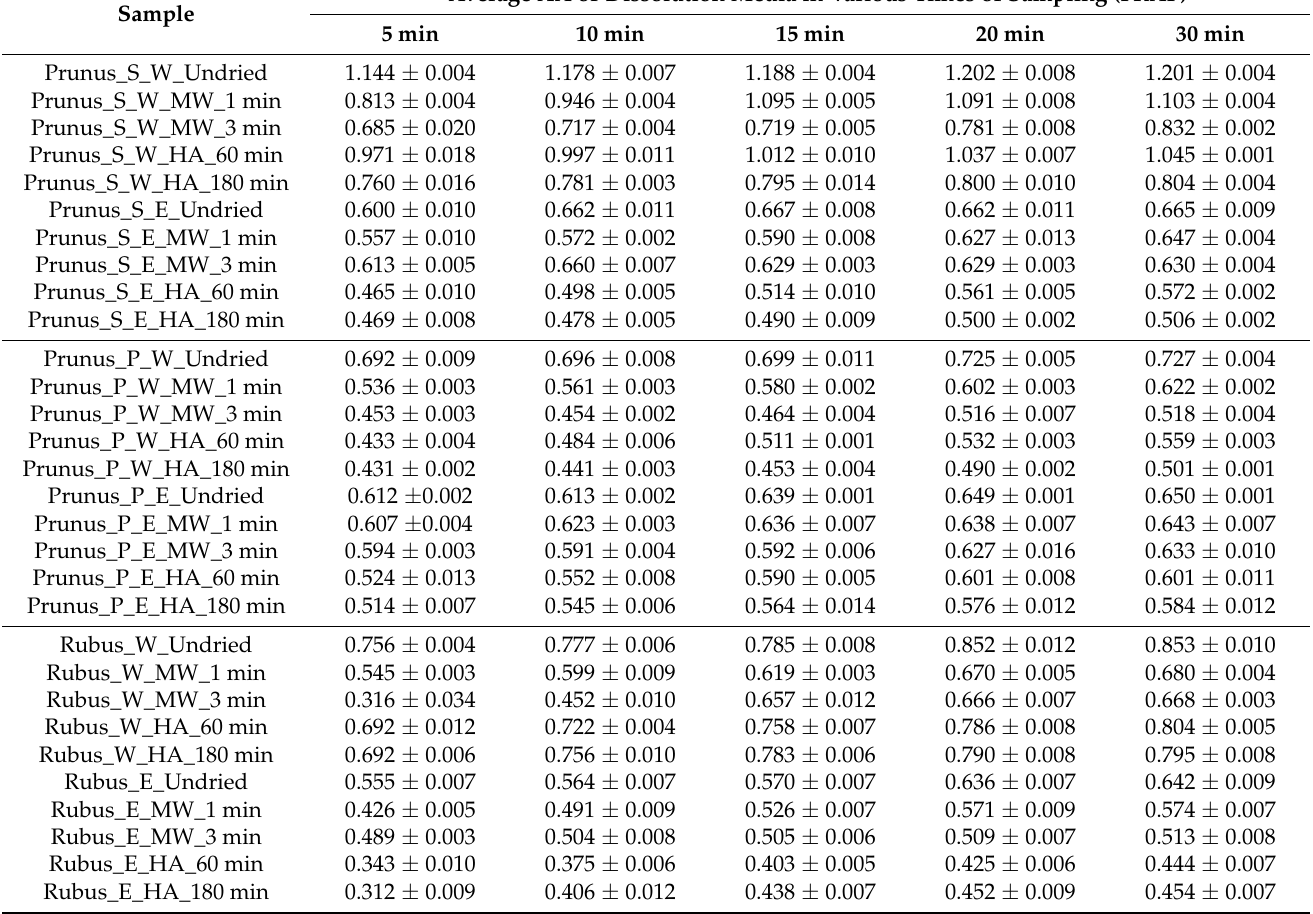
Table 7. Average AA of tablets with plant